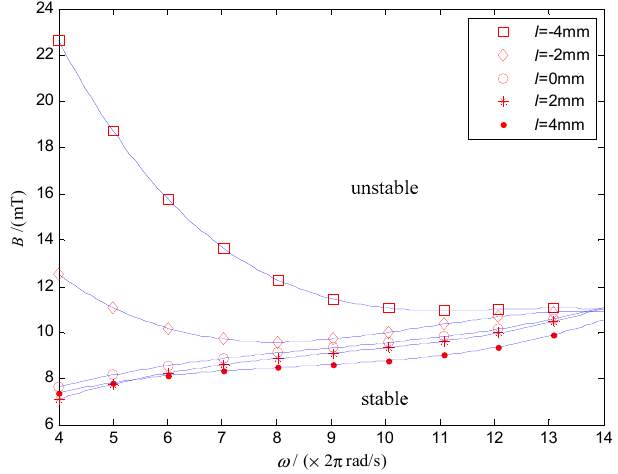
Figure 13. Stability domain of the DSCR for the periodic motion.